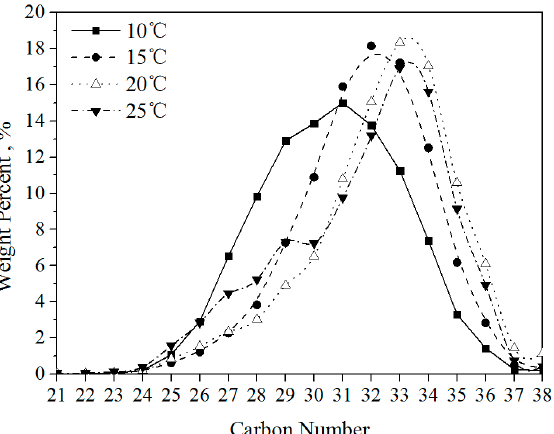
Figure 8. The carbon number distribution of precipitated wax at 25 °C, 20 °C, 15 °C and 10 °C for 10% artificial oil.